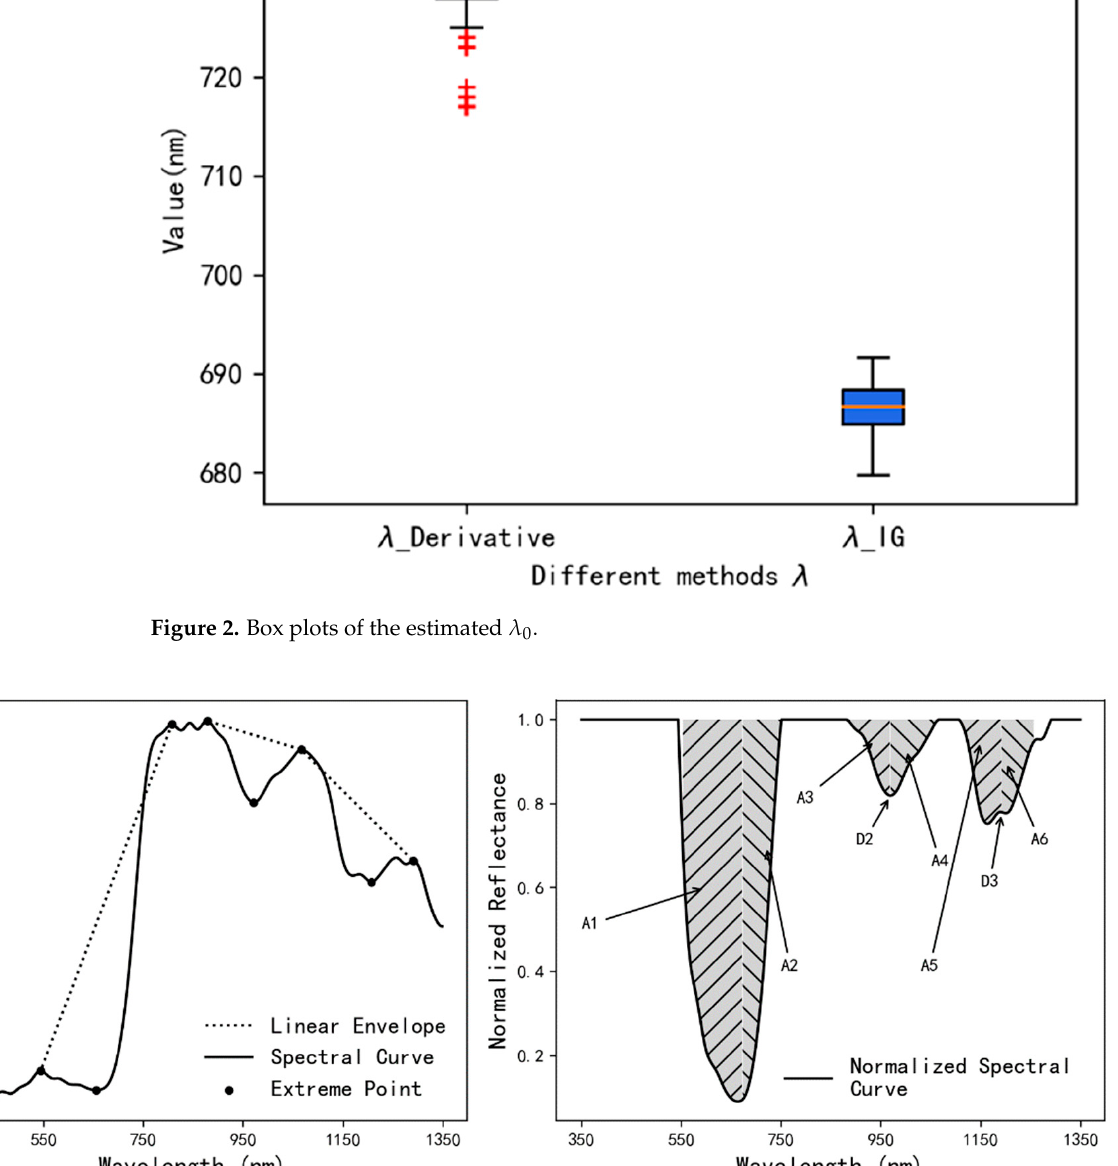
Figure 2. Box plots of the estimated 𝜆 (cid:2868)